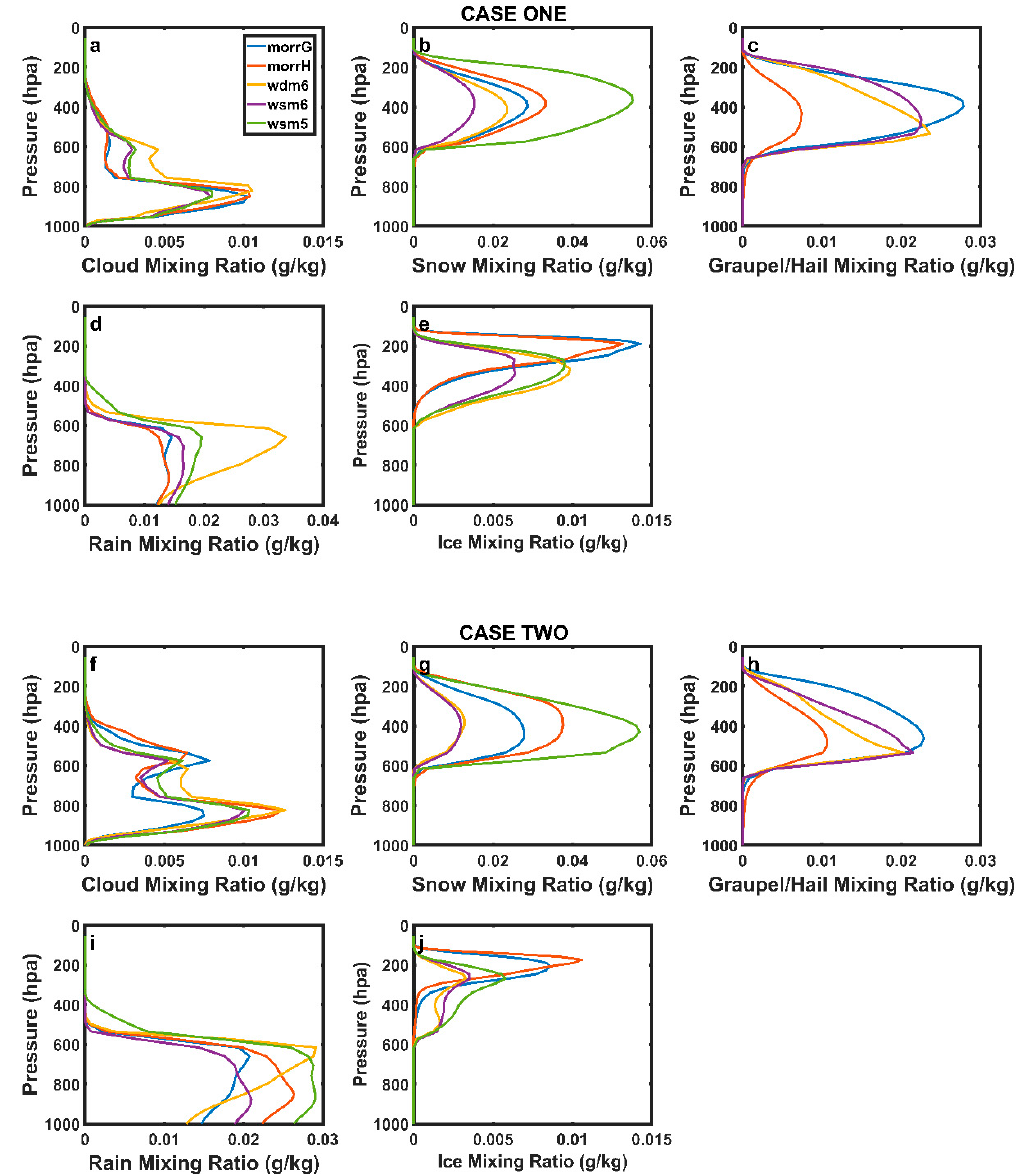
Figure 4. Area average (5 °N–9 °E, 4 °N–6 °N) of vertical profile distribution of mass mixing ratio for CASE ONE ( a ) cloud ( b ) snow ( c ) graupel / hail ( d ) rain and ( e ) ice and CASE TWO ( f ) cloud ( g ) snow ( h ) graupel / hail ( i ) rain and ( j ) ice.